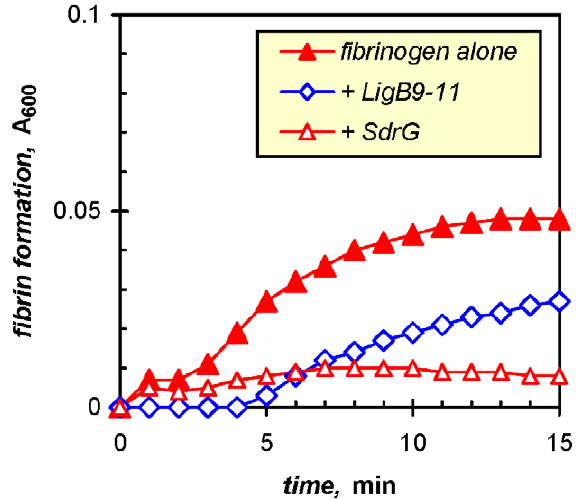
Figure 1. LigB binds fibrinogen and inhibits fibrin formation. Thrombin-catalyzed clotting was measured spectrophotometrically